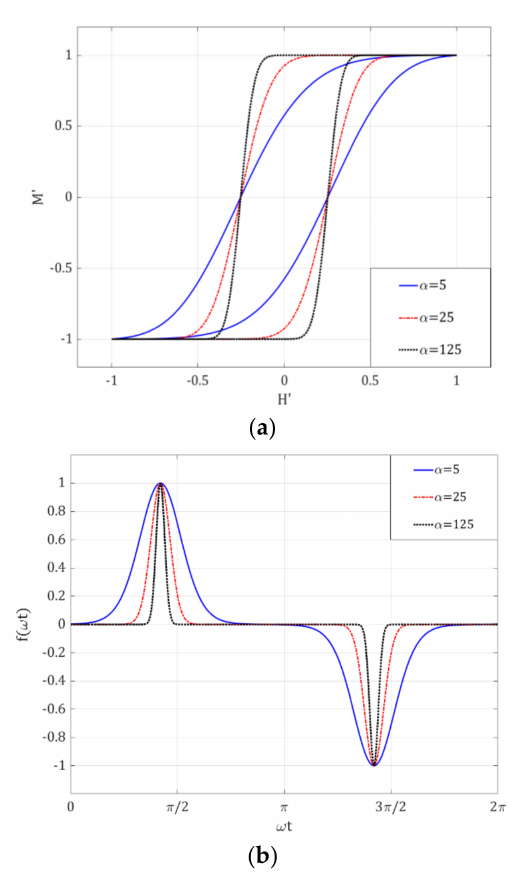
Figure 3. Effect of α on normalized hysteresis loops ( a ) and corresponding functions ( b